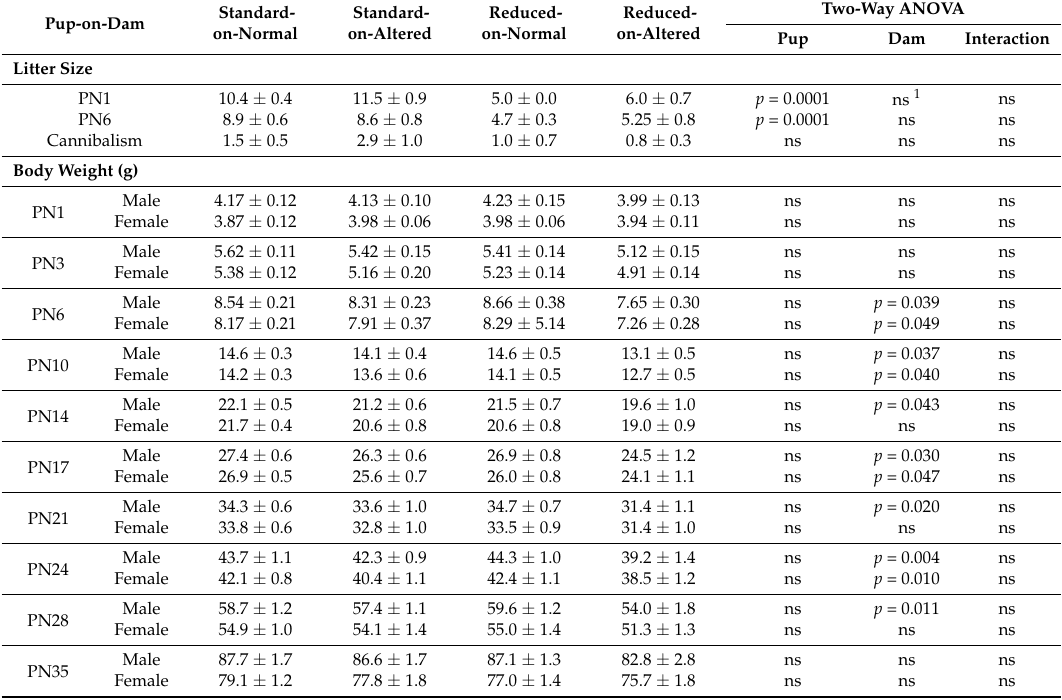
Table 1. Cross-fostered litter size at postnatal day (PN) 6 and body weight from birth (PN1) to weaning (PN35) ( n = 12–18 litter averages per group). Two-Way ANOVA Standard- Standard- Reduced- Reduced- on-Normal on-Altered on-Normal on-Altered Pup Dam